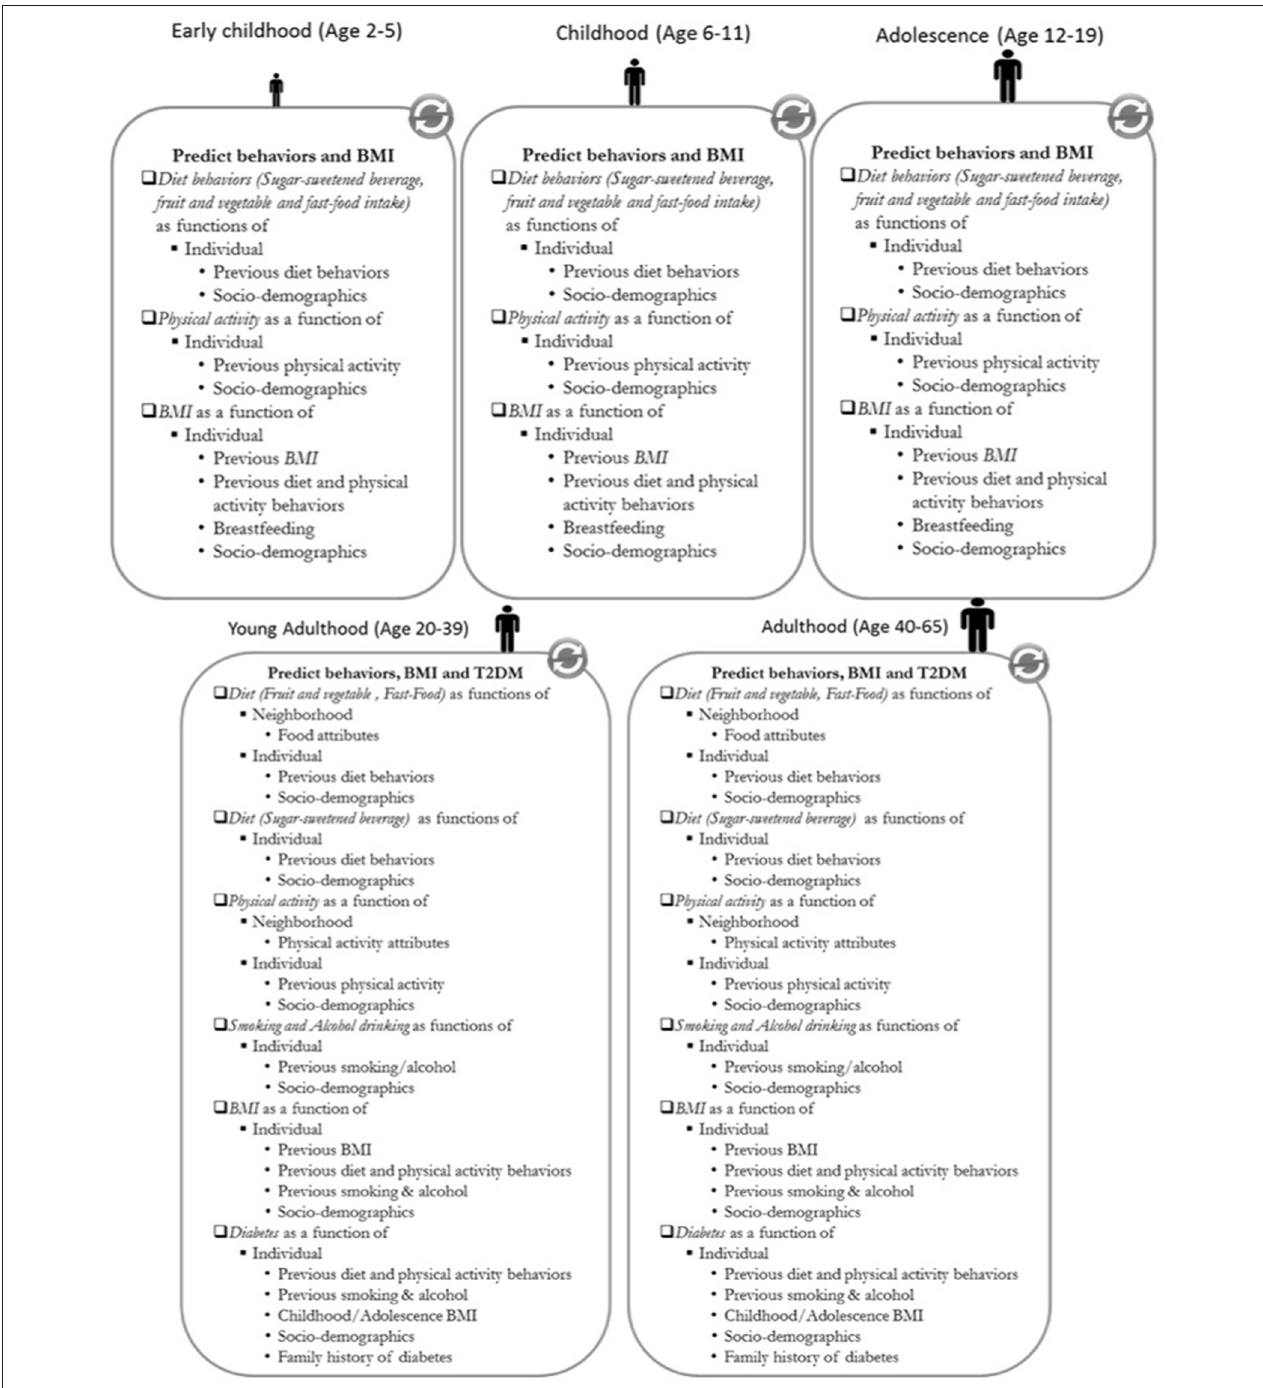
FIGURE 3 | Model execution diagram of the ViLA-Obesity model. BMI, body mass index; T2DM, type 2 diabetes; SES, Socio-economic status. Individual behaviors are predicted based on the agent’s socio-demographics, previous behavior and depending on the behavior neighborhood characteristics. The body mass index and type 2 diabetes are predicted based on the agent’s socio-demographics, previous behaviors, and previous body mass index in the case of body mass index. [ACS] (19). The second domain was the